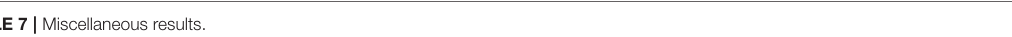
TABLE 7 | Miscellaneous